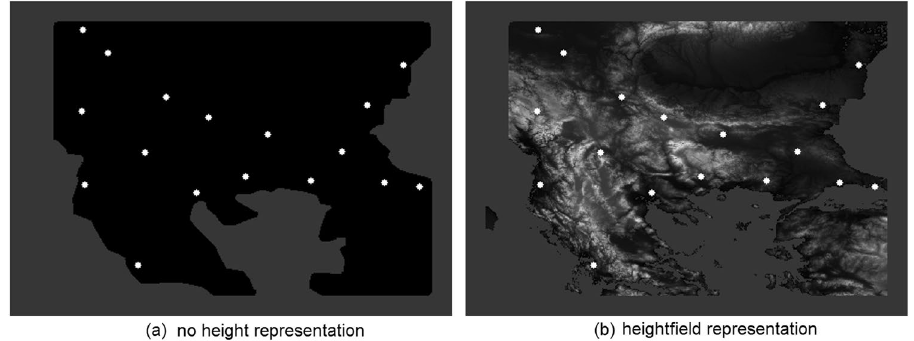
Figure 8. Representations of arenas used in modelling experiments. ( a ) Arena with borders of the Balkans region and no height representation, region locations represented as attractant sites (white dots), ( b ) arena represented by a greyscale topographic heightfield map where pixel intensity corresponds to landscape height, region locations represented as attractant sites (white dots) (Figure, data points and heightfield representation from custom Processing script (https://www.processing.org/) by author J.J. See text for further details).